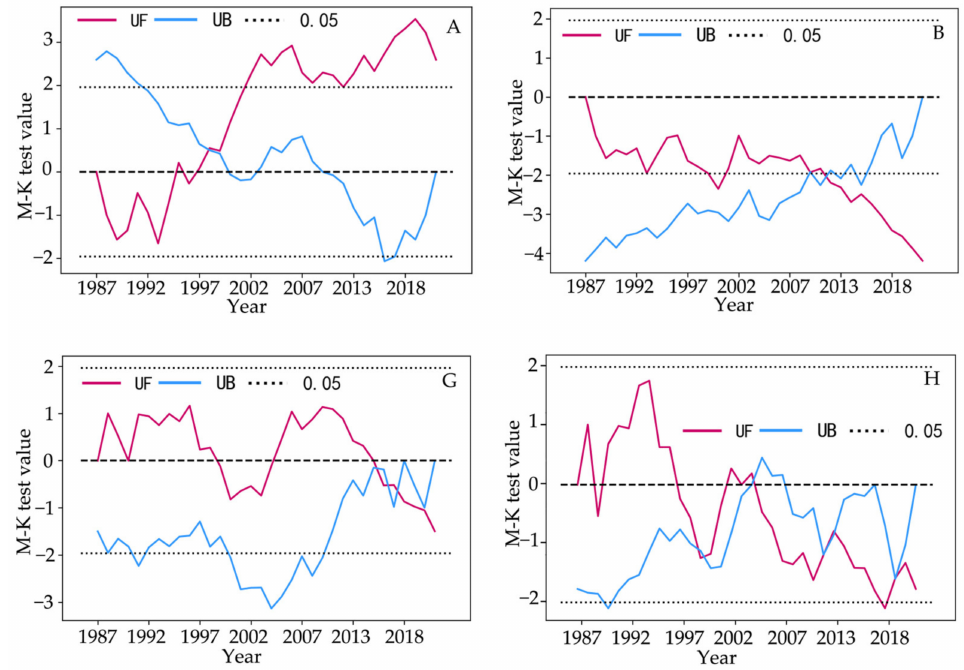
Figure 12. Temporal trend of SSC at sites A, B, G, and H (UB and UF are changing parameters where UB is the reverse of